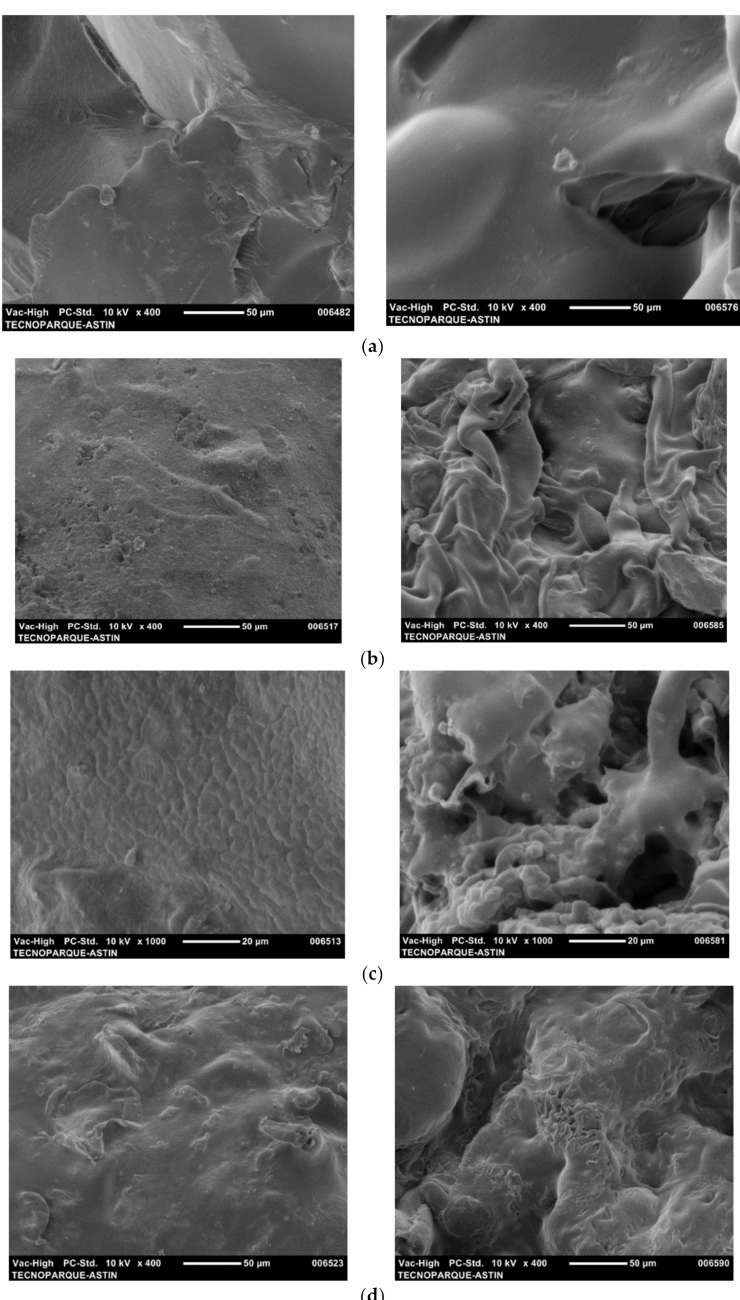
Figure 3. Scanning electron micrographs (SEM) of non-lyophilized (left) and lyophilized (right) hydrogels: ( a ) AHR0, ( b ) AHR3, ( c ) AHR5, and ( d )